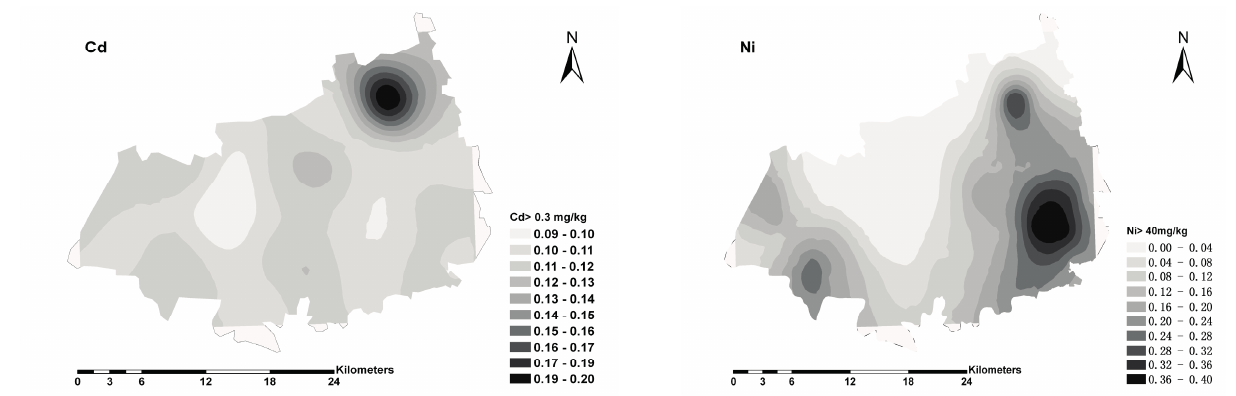
Figure 5. The estimated probability map of Cd and